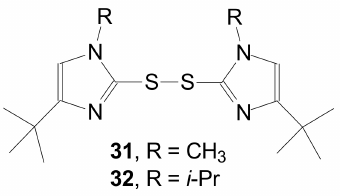
Figure 4. Imidazole disulfide reagent for